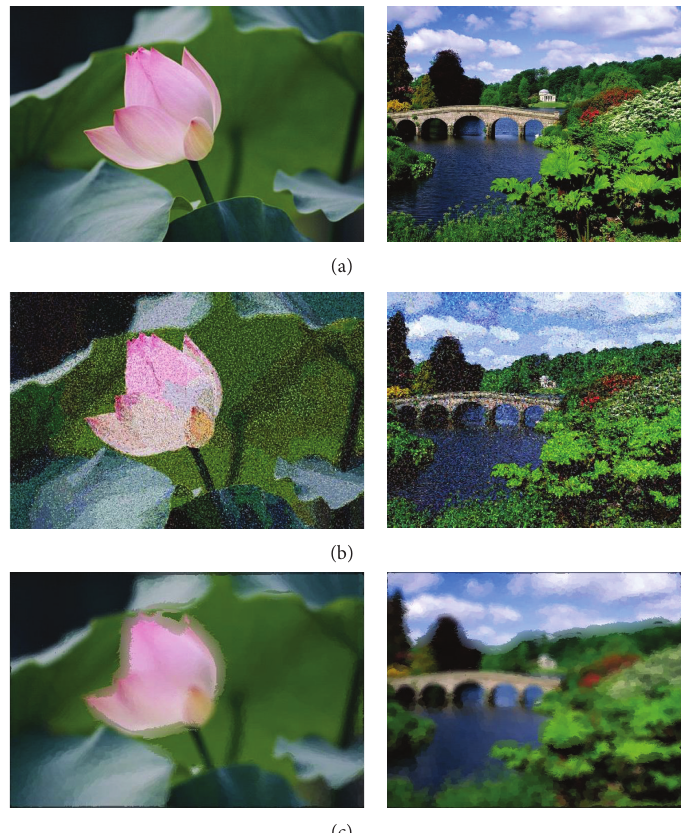
Figure 11: Comparisons between our method and Wu’s method. The source images are in the first row; the second row and third row are Wu’s results and our results. The maximal and minimal dot sizes of our method are 13 and 5, respectively, which are similar to Wu’s dot